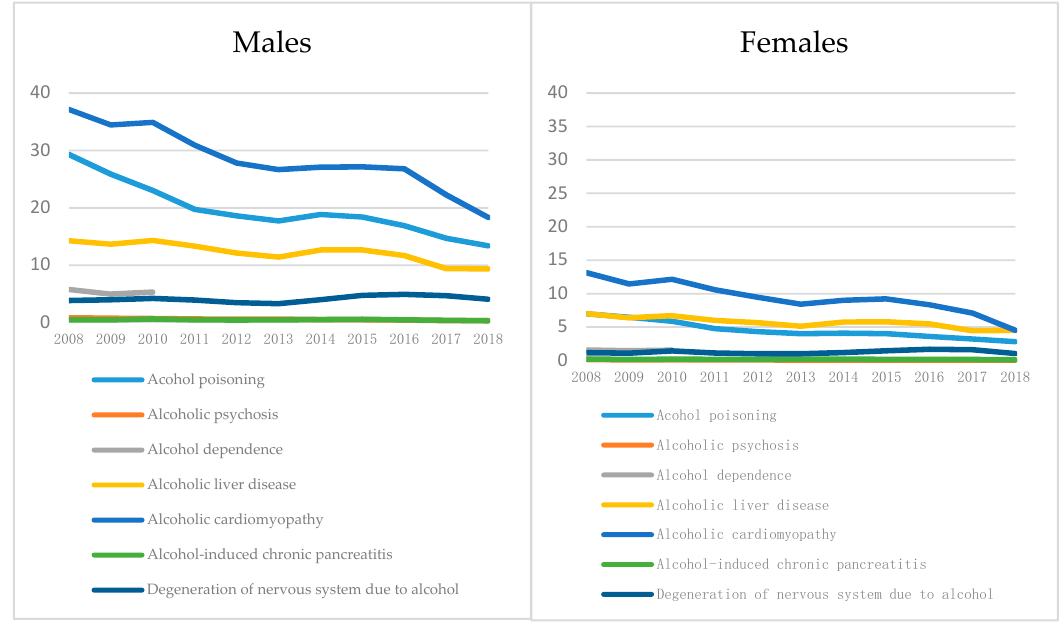
Figure 7. Age-standardized death rates per 100,000 for 100% alcohol-attributable causes of death. Source: Russian Fertility and Mortality Database. Adapted from: World Health Organization Regional Office for Europe, 2019 [11].